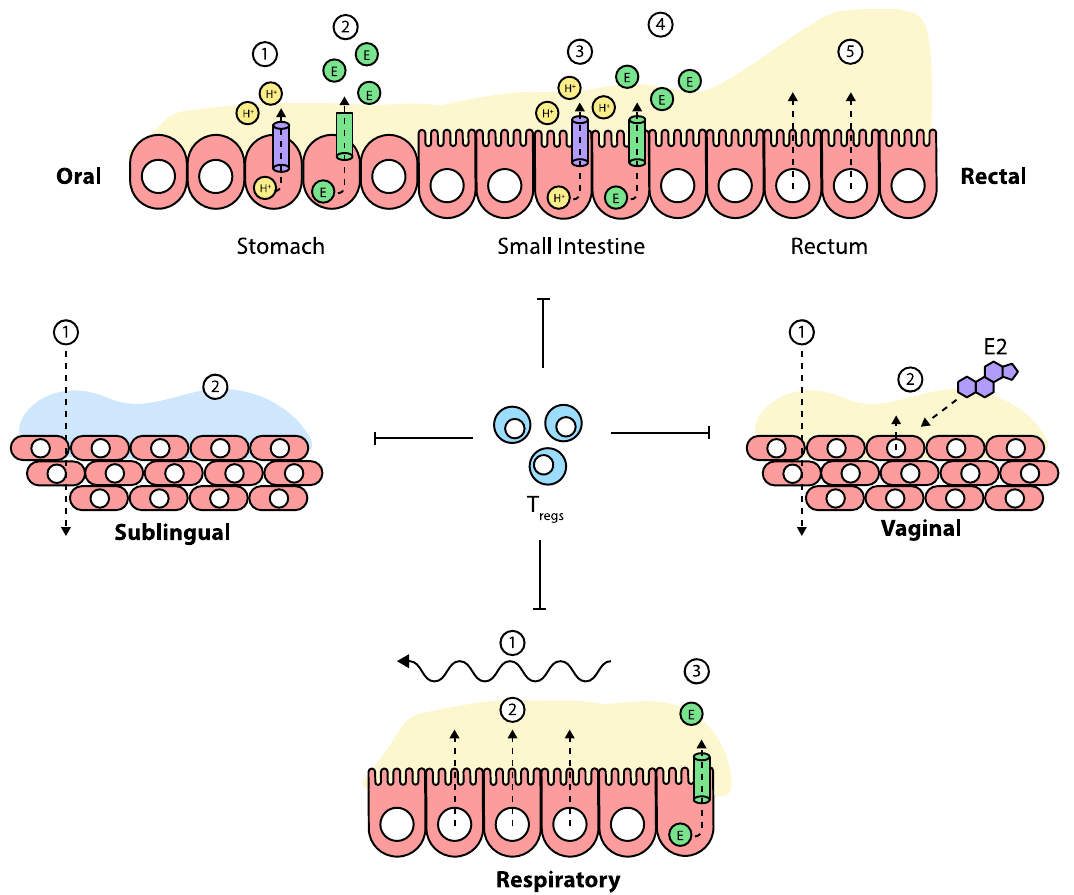
Fig. 6 Challenges encountered in the mucosal environment. Following sublingual immunization, the antigen faces challenges associated with the (1) crossing of the strati fi ed epithelium and (2) salivary dilution of antigen. With oral immunization, the vaccine faces challenges in different regions along the GIT. In the stomach, there are challenges due to the (1) destructive action of the acidic environment and (2) the degradative action of enzymes. In the small intestine, the challenges faced are those impacted by the (3) pH variation, (4) degradative enzymes and (5) intestinal mucus in addition to the intrinsic immunotolerance. At the rectal mucosa, the problem faced is those impacted by the (5) thick mucus layer and the tolerogenic microenvironment. Following nasal immunization, at the respiratory mucosa, the vaccine faces challenges due to the (1,2) mucociliary action of the ciliated epithelium which continually pushes the antigen, a process that reduces residence time, the (2) low-grade enzymatic action of RNAses and also the intrinsic immunotolerance. At the vaginal mucosa, the challenges are due to the mucus layer which thickens with increased estradiol (E2) level and reduces uptake as well as the immunotolerance with the low immunogenic response which is often limited to the local genital tract. The epithelial barrier formed by the epithelial layer of cells is a limiting factor to vaccine uptake which is common in all mucosal